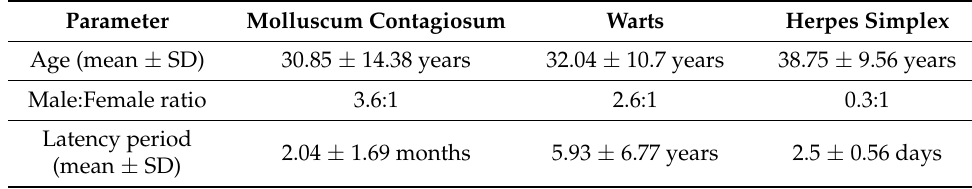
Table 4. Demographic characteristics of the reported